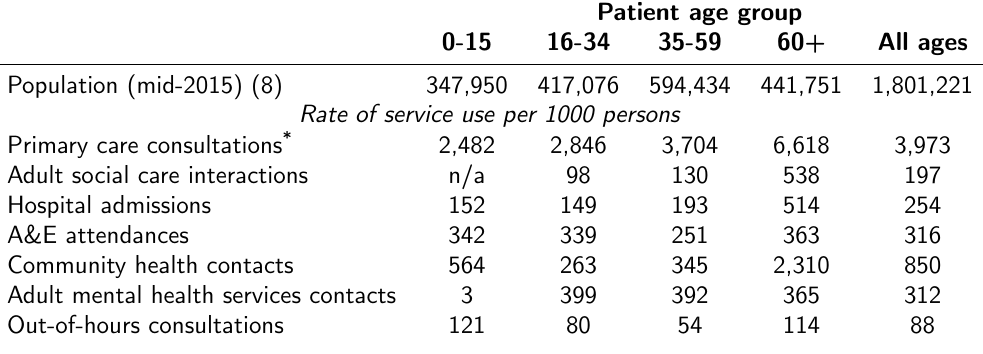
Table 3: Rate of service use recorded in the Kent Integrated Dataset, by age group,